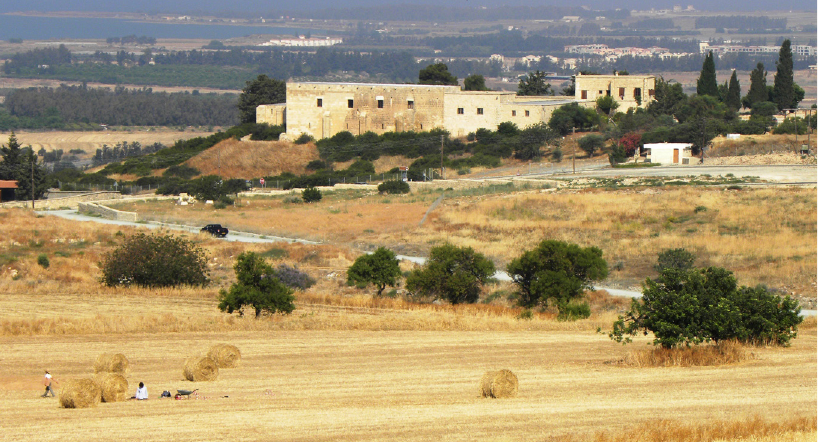
Figure 23. View from the Hadjiabdoulla citadel plateau towards the coast (SW) and the sanctuary precinct, which is hidden by the Mediaeval Manor House. Photo by author